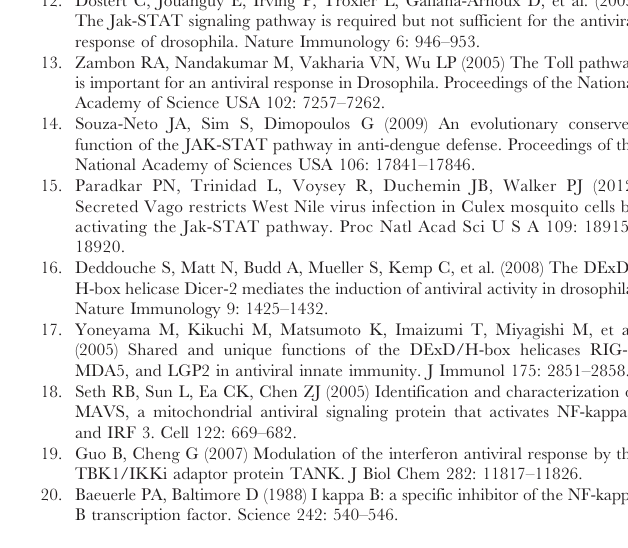
Figure S1 Protein sequence alignment of human NF-kB (p105 subunit; NP_003989) and Culex Rel2 (XP_001862276) using ClustalW2. Figure S2 Protein sequence alignment of Human (NP_665802) and Culex (XP_001846690) TRAF6 using ClustalW2. Figure S3 Hsu cells were transfected with plasmid containing the Vago-Luciferase (and firefly luciferase control plasmid). At 24 h post-transfection, the cells were infected with WNV or treated with Vago-containing media and luciferase activity was measured at 24 hpi. The Renilla luciferase activity values were standardised using firefly luciferase activity values (R/F) and resulting values were plotted as bar graphs. Error bars represents standard error from experiment with assays performed in triplicates (Student’s t-test *p , 0.05) and values were compared with control cells.